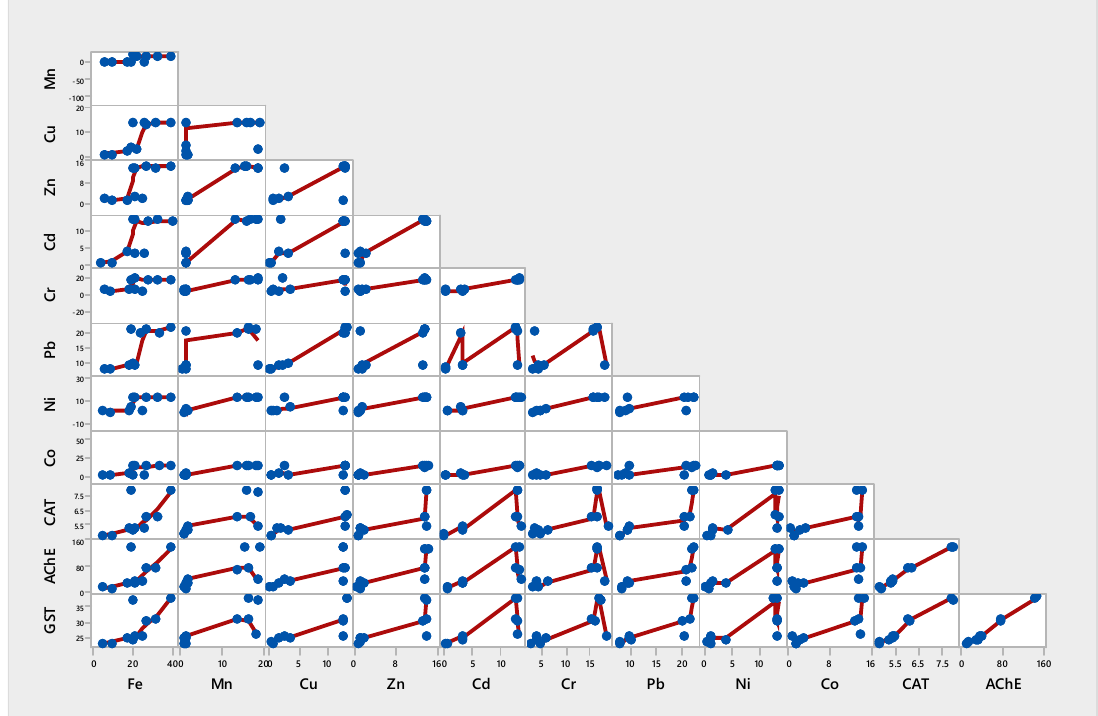
Figure 6. Multivariate Item Analysis (MIA) for antioxidant enzymes and metallic concentrations in a freshwater snail. CAT = Catalase, AChE = Acetylcholinesterase, GST = Glutathione-S-transferase.